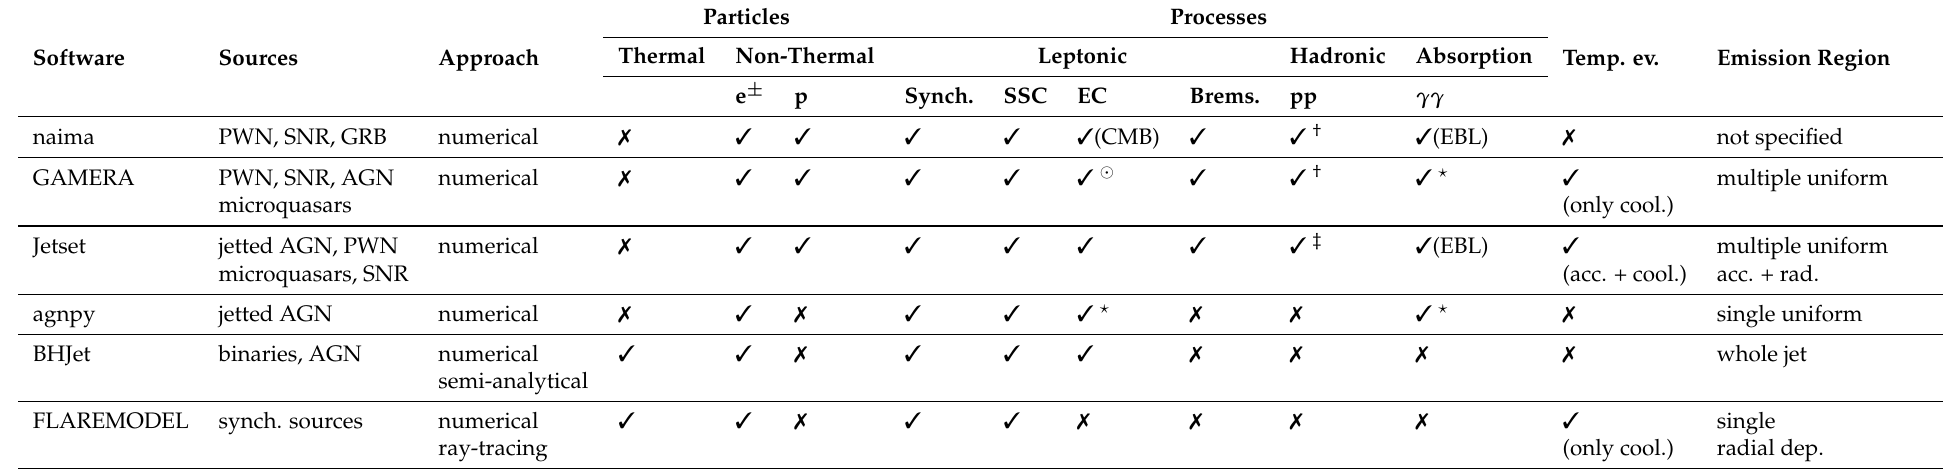
ray-tracing (only cool.) radial